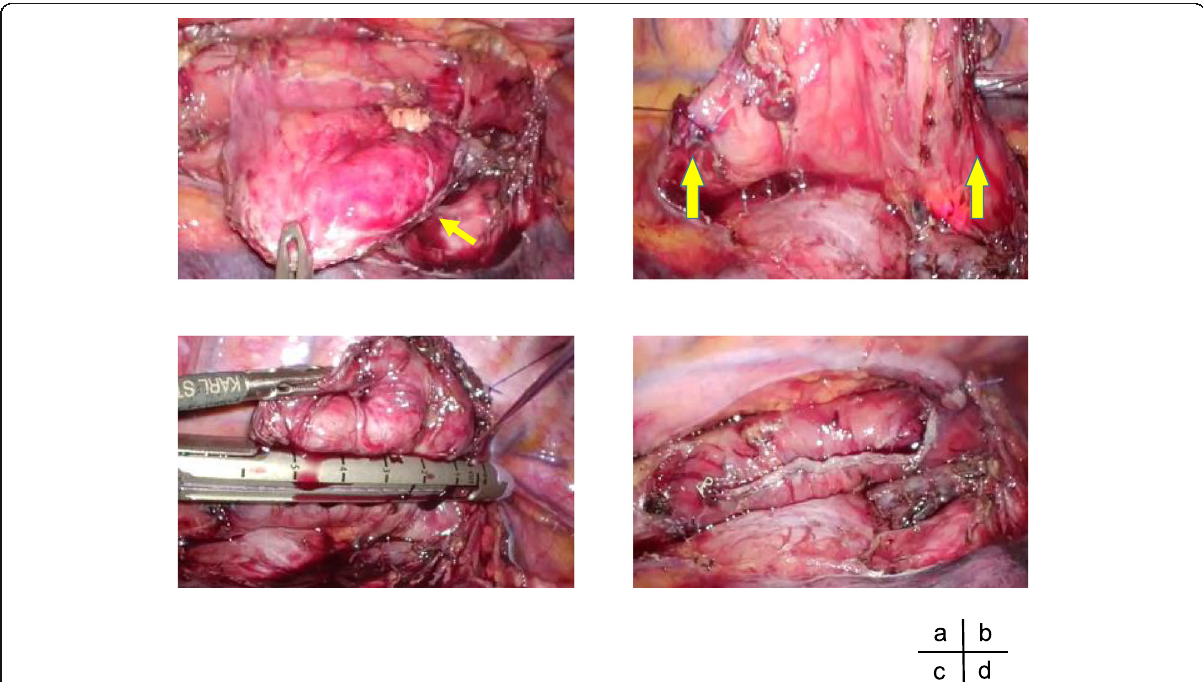
Fig. 3 Intraoperative findings. a The diverticulum was exposed from the surrounding tissue (arrow). b The diverticulum was pulled upwards using anchor threads. c A diverticulectomy was performed using a linear stapler. d No leakage or bleeding were observed after the